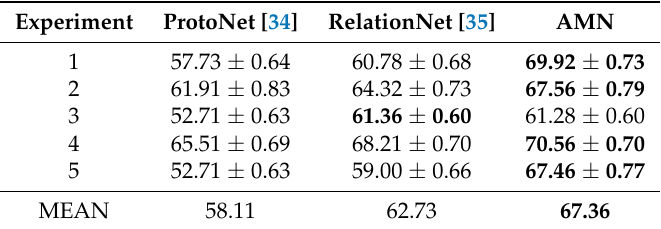
Table 4. Average accuracy(%) and 95% confidence interval(%) of ProtoNet, RelationNet and AMN on the RSD46-WHU dataset, each experiment contains 600 randomly selected tasks. The best results on each experiment are marked in